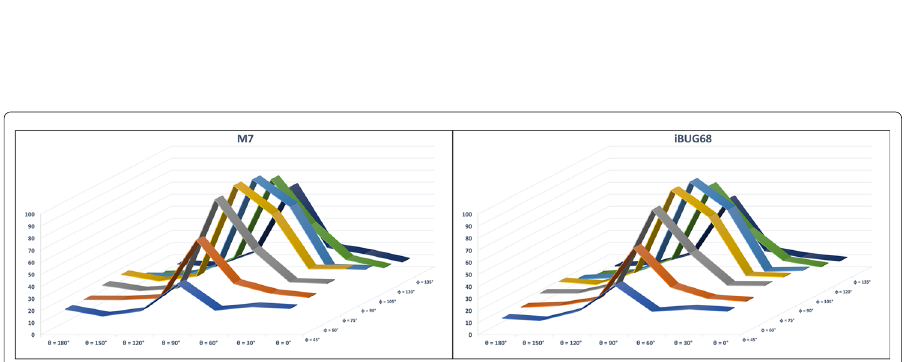
Fig. 14 HAAM: camera position varying across φ (from 45 ◦ to 135 ◦ ) and θ (from 0 ◦ to 180 ◦ )